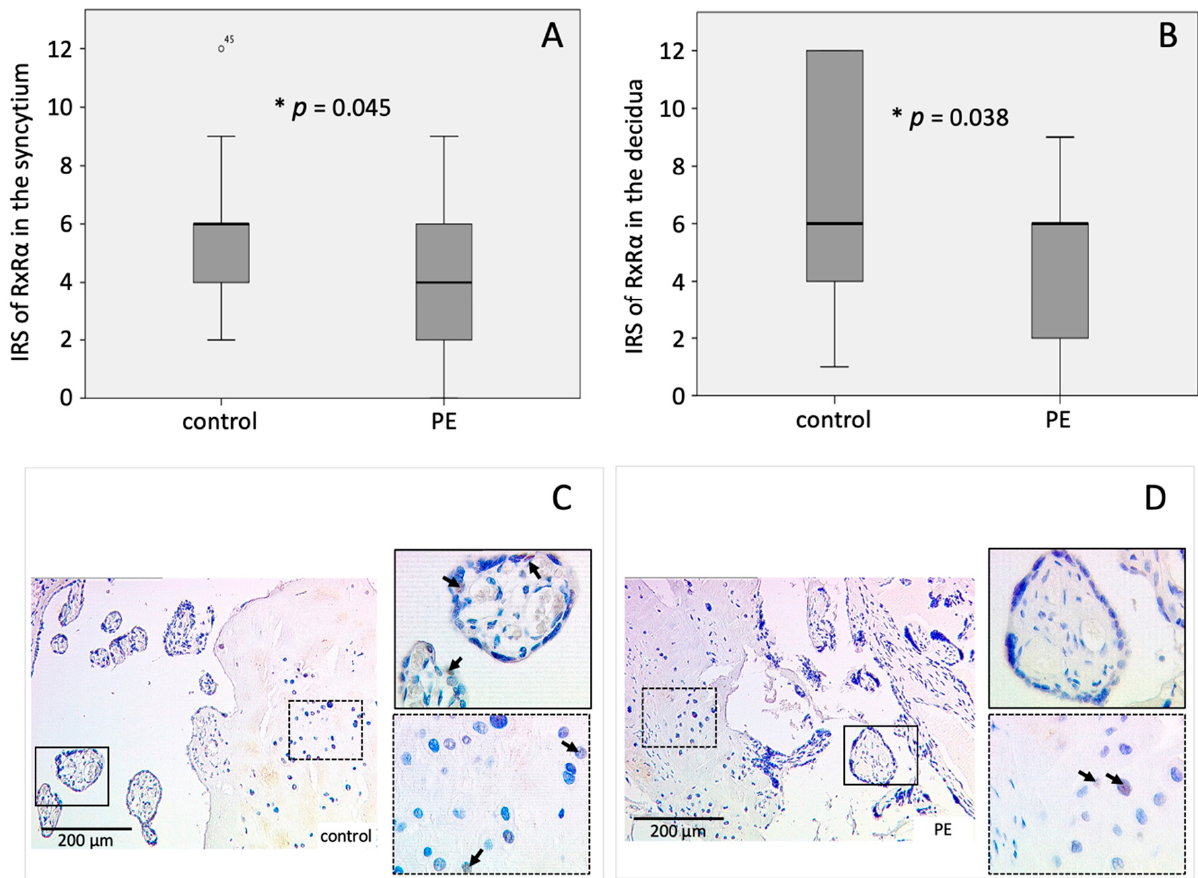
Figure 2. Immunohistochemical staining results of RxR α . Boxplots of the IRS in the ( A ) syncytiotrophoblast and ( B ) the decidua as mean ± SD; p -values were calculated with Mann–Withney-U-Test; representative immunohistochemical images of RxR α in controls ( C ) and PE placentas ( D ) were chosen, continuous line: syncytium, dotted line: decidua. IRS of control placenta: syncytiotrophoblast = 4, decidua = 3; IRS of PE placenta: syncytiotrophoblast = 1 decidua = 2. The respective p -value indicates, if the IRS of controls and PE differ significantly and was calculated using the Mann-Whitney-U-Test.